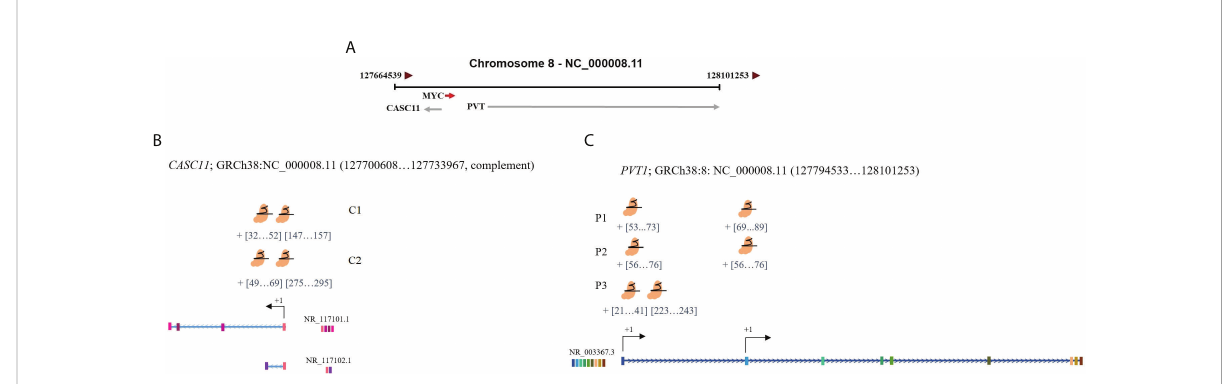
FIGURE 3 Schematic representation of the target positions of designed guides for PVT1 and CASC11 . (A) PVT1 and CASC11 are located downstream and upstream of MYC . (B) CASC11 -sgRNAs and (C) PVT1 -sgRNA target sites are near TSS. TSS, transcription start